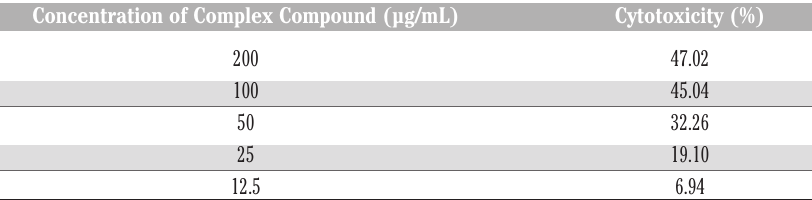
Table 3. The viability Vero cells after treatment with [Cu(2,4,5-triphenyl-1 H - imidazole)